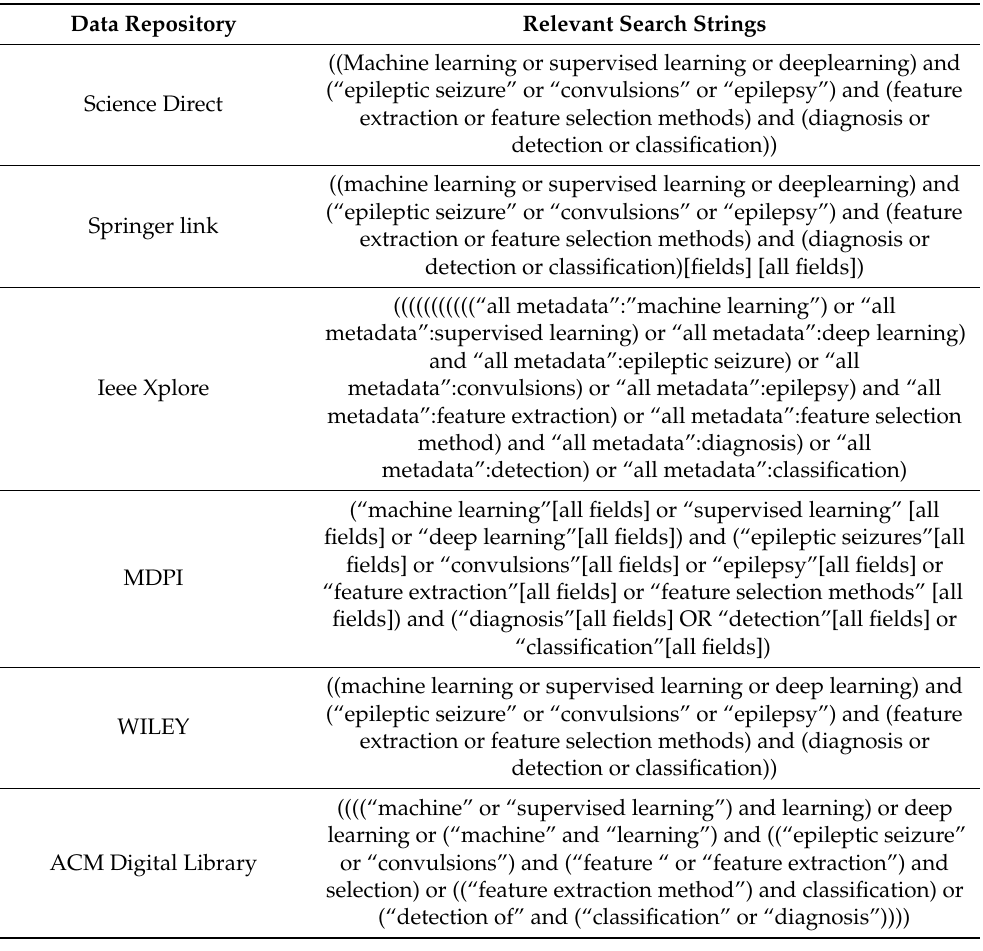
Table 3. Publisher-wise search